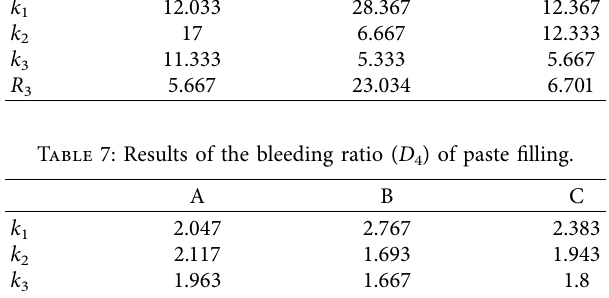
Table 8: Results of the compressive strength ( D